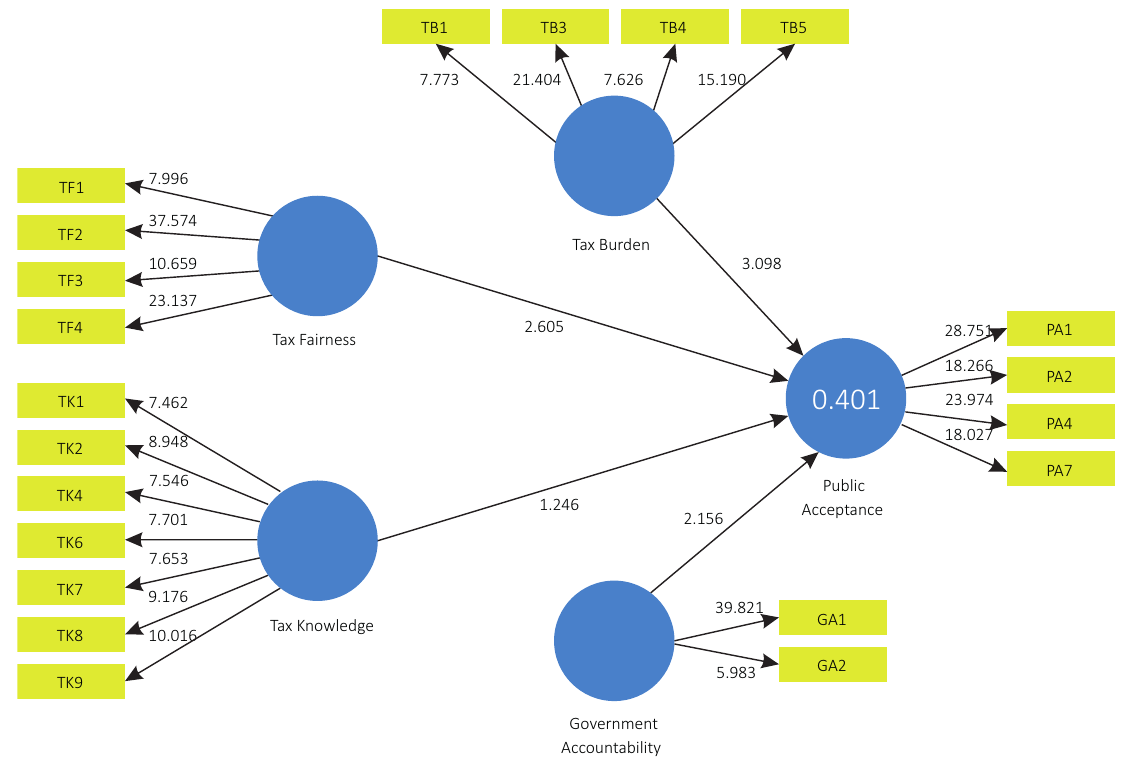
Figure 5. Direct relationship hypotheses testing (bootstrapping